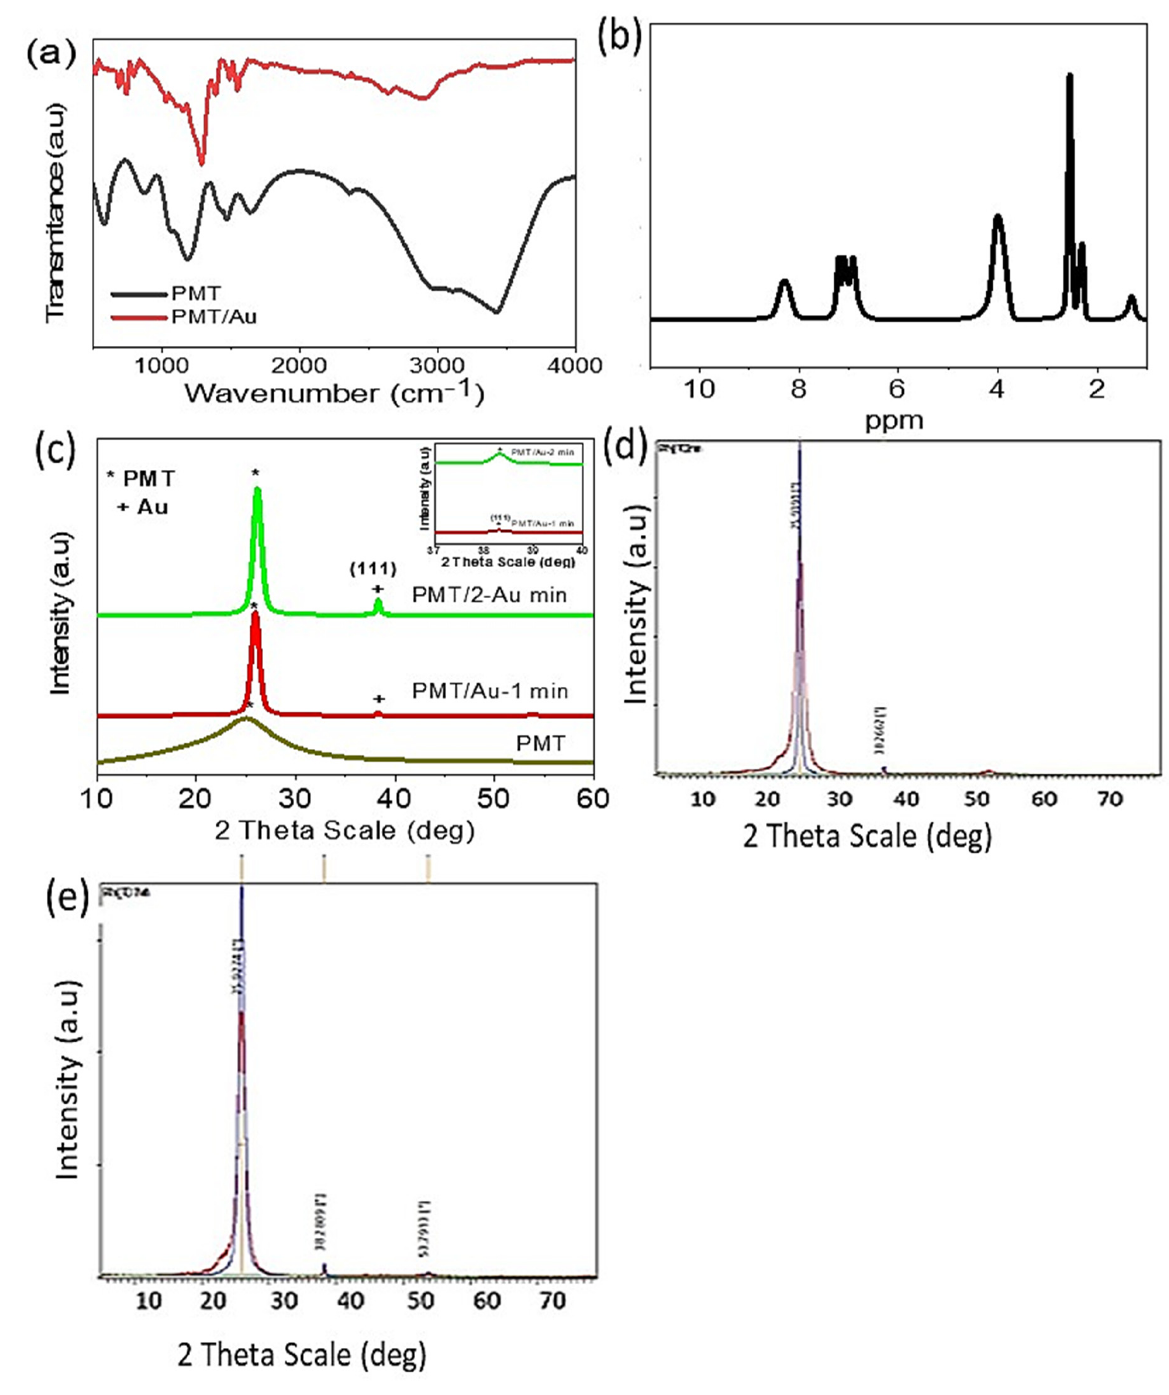
Figure 2. ( a ) FT-IR and ( b ) 1 HNMR of PMT. ( c ) XRD of PMT, PMT/Au-1 min and PMT/Au-2 min. ( d , e ) Standard stick pattern for ITO/PMT/Au-1 min and ITO/PMT/Au-2 min, respectively.